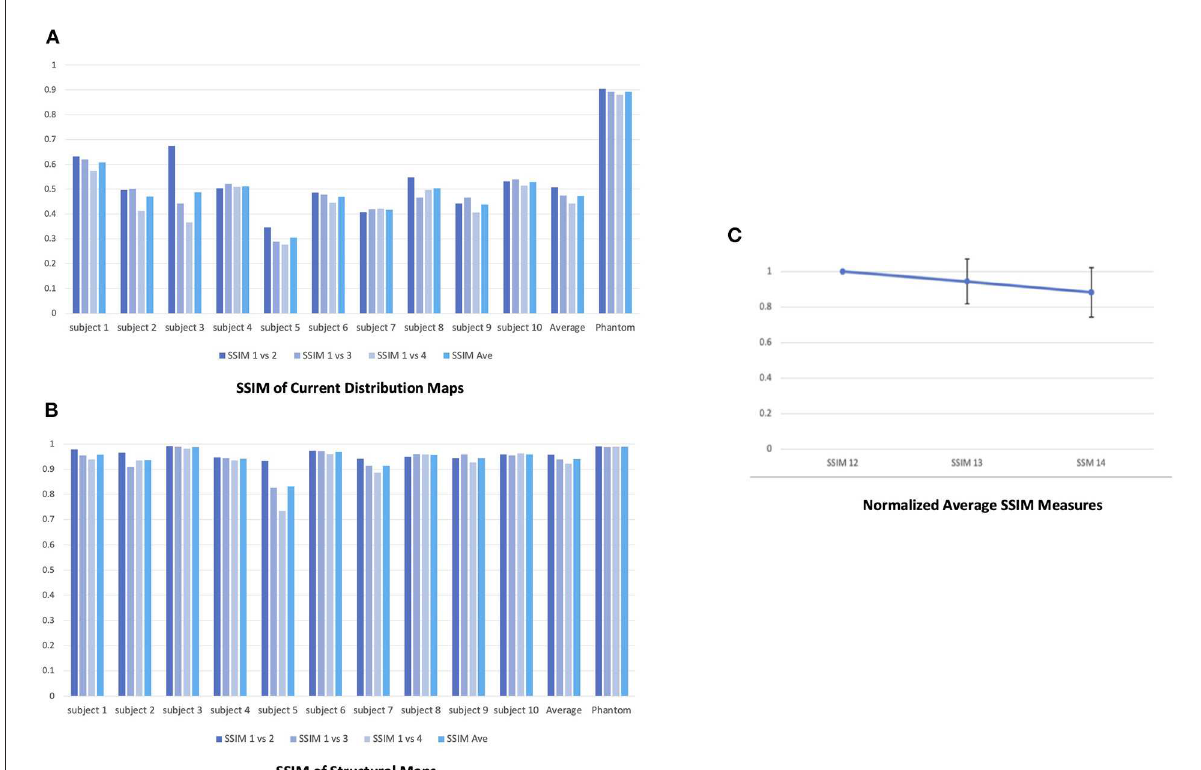
FIGURE6 Repeatability of the four consecutive stimulation scans in the phantom and human subjects. (A) SSIM measures of the current distribution maps across the four scans in the phantom and human subjects. For both the phantom and each human subject, we took the current distribution map from the first of the four consecutive scans as reference and calculated SSIM between the maps from the reference and second (SSIM12), the reference and third (SSIM13), and the reference and fourth scans (SSIM14) to quantify the changes in the maps. (B) SSIM measures of the structural maps across the four scans in the phantom and human subjects. (C) The normalized average SSIM measures of the current distribution maps across all subjects. The normalized SSIM measures showed a decreasing trend in the similarity of the current maps across the time [1 (SSIM12); 0.945 (SSIM13; STD = 0.126); 0.884 (SSIM14; STD =